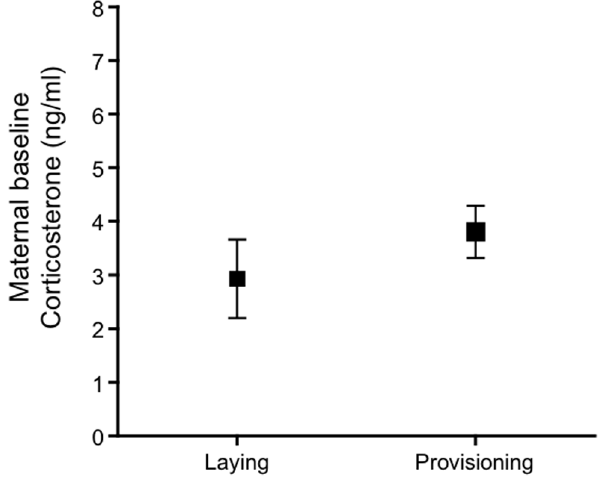
Figure 1. Maternal baseline CORT did not significantly differ when measured during egg laying versus nestling provisioning ( n =laying: 9, provisioning: 10). Graph shows mean 6 SE.